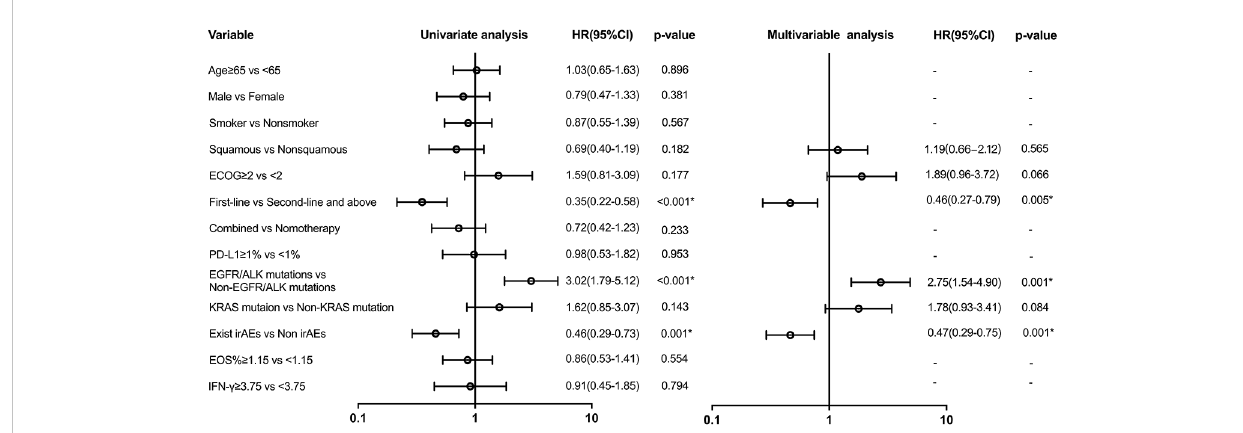
FIGURE 4 Univariate and multivariable predictors of progression-free survival. Variables with p -value ≤ 0.2 in univariate models were analyzed in a multivariate analysis model. EGFR, epidermal growth factor receptor; ALK, anaplastic lymphoma kinase; KRAS, Kirsten rat sarcoma viral oncogene homolog; irAEs, immune-related adverse events; HR, hazard ratio; CI, con fi dence interval. *